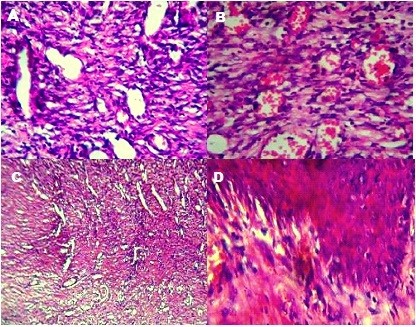
Histopatholigically, Nitrofurazone treatments groups are in different days. A Four day inflammatory responses associated with intradermal immune infiltrates with promoting angiogenesis, B: Eighth day Excessive inflammation and angiogenesis during wound healing, C: Twelfth and sixteenth days; Loss of epithelial integrity associated with abundant angiogenesis and inflammation cells and epithelial tissues are formed by cells that cover the organ surface but not completed unlike Kumbucha, D: Twentieth day healing is crazy acceptable, closing up of the wounds with out inflammation and dermal appendages destroyed.